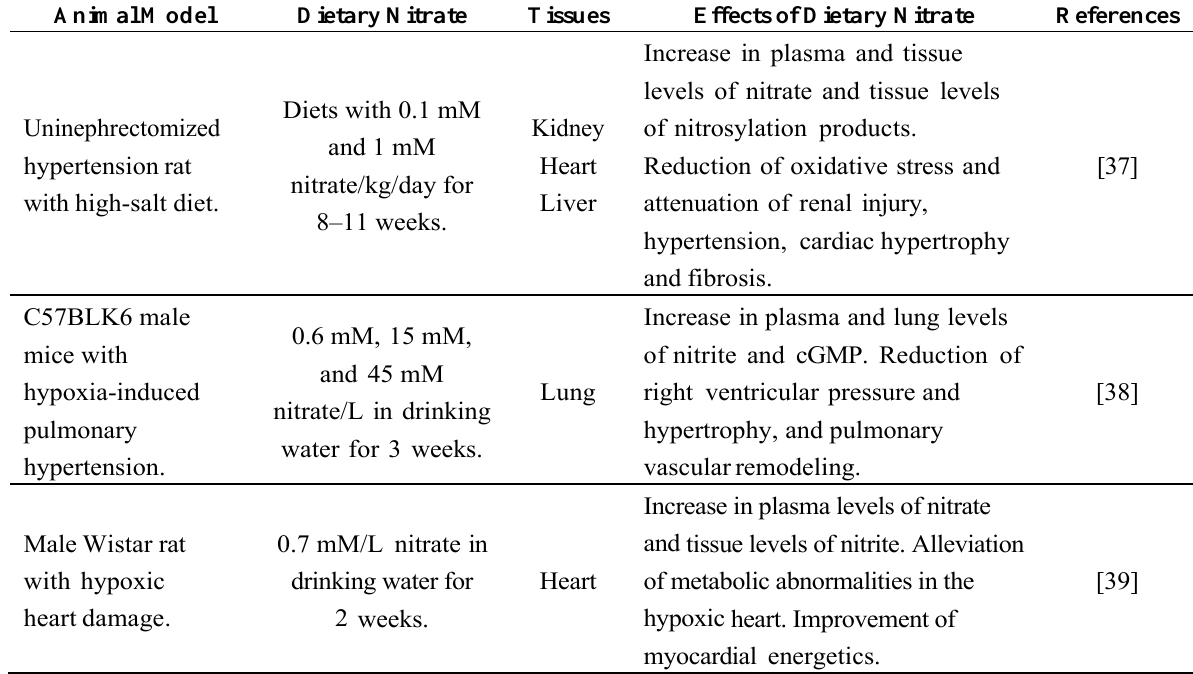
Table 3. The effects of chronic dietary nitrate supplementation on tissue levels of nitrate/nitrite and therapeutic efficacy for experimental animal